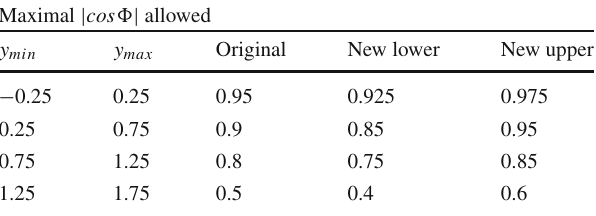
Table 1 Numerical values for cos (cid:4) cut used for systematic uncertain- ties calculation Maximal | cos (cid:4) | allowed